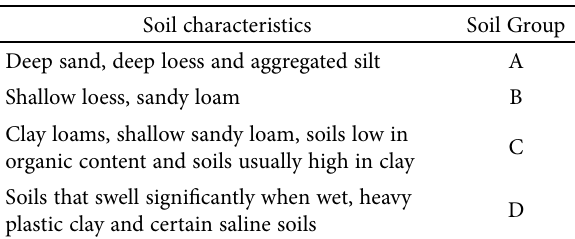
Table 1. Different hydrologic soil group classification